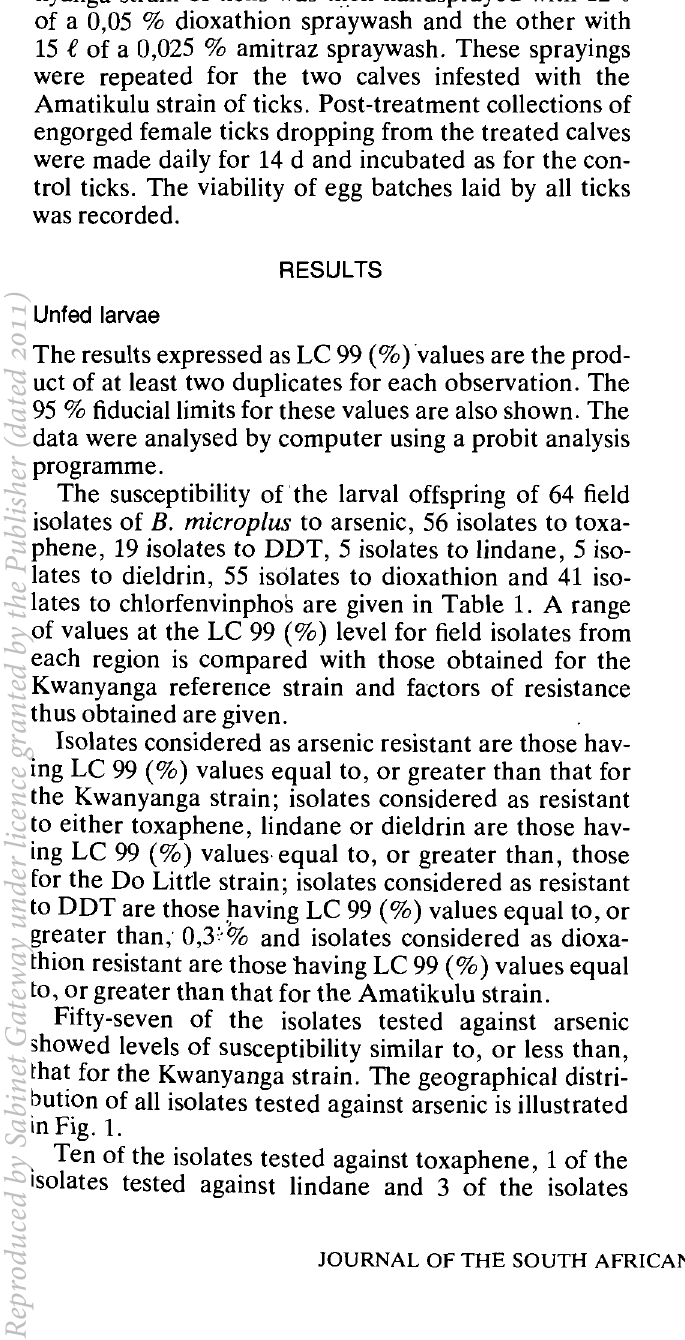
Fig. 1. Geographical distribution of the arsenic susceptible and re sistant strains of Boophilus microplus recorded in Table 1.